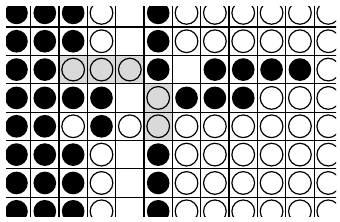
Figure 46. BLACK wins.